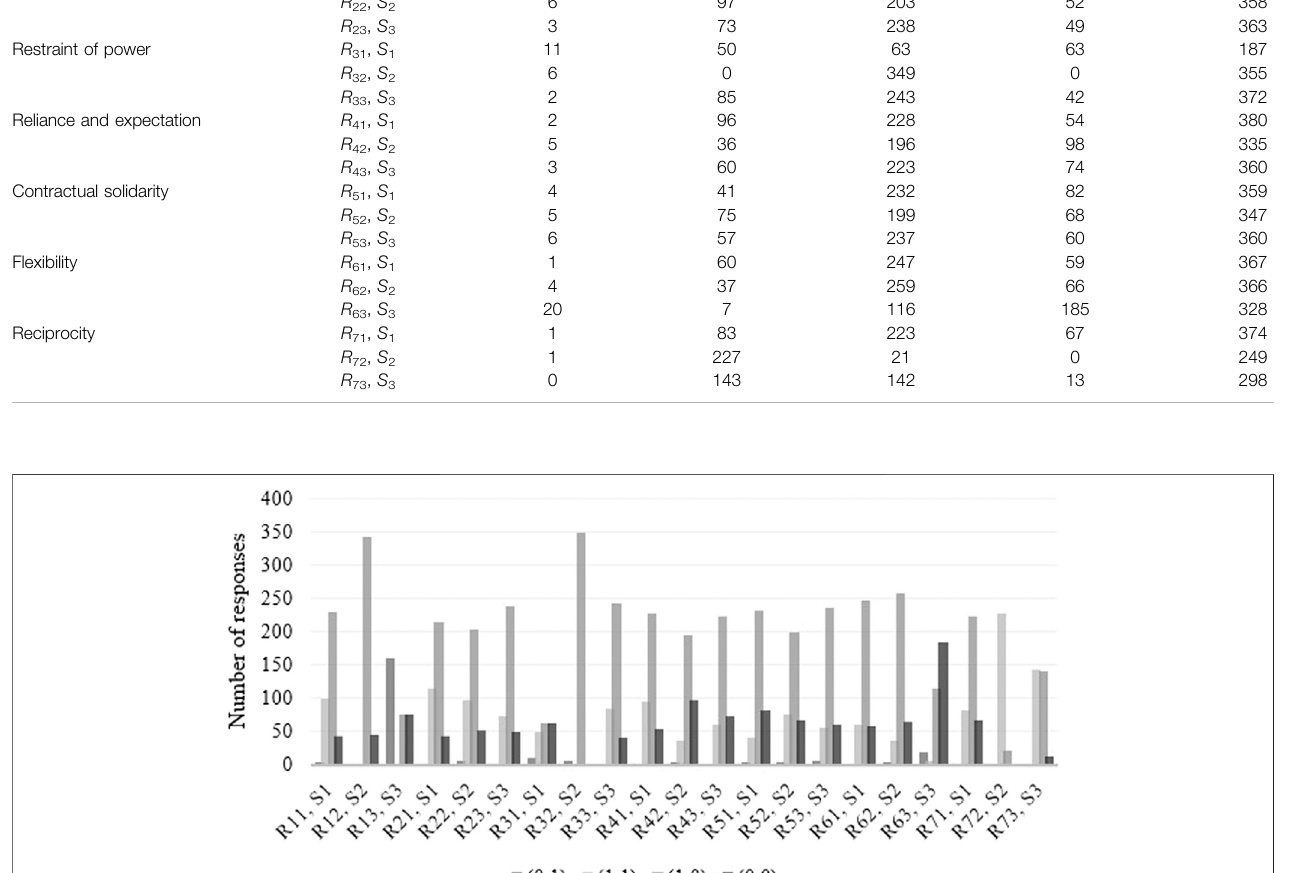
social behavior. The index variable m ranges from 1 to 7 and n